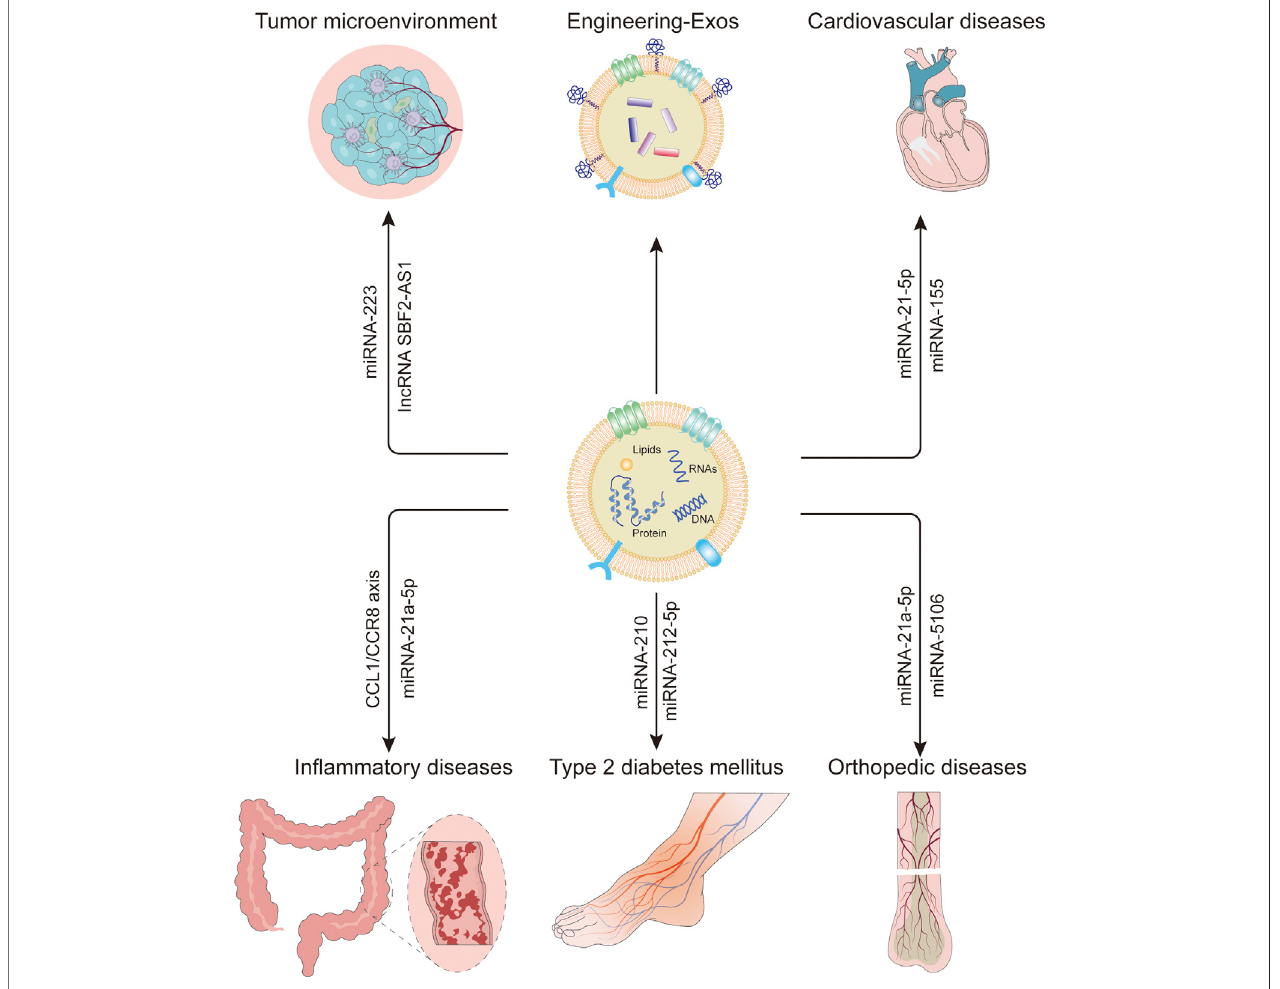
FIGURE2| Macrophage-derivedexosomesaffectdiseaseandapplications.M-Exoscontaindifferenttypesofcontentsthathavedifferentfunctionsinmultifarious diseases in vivo . In addition, they cannot only be used as drug carriers but also as biomarkers and can change the microenvironment to enhance drug ef fi cacy.